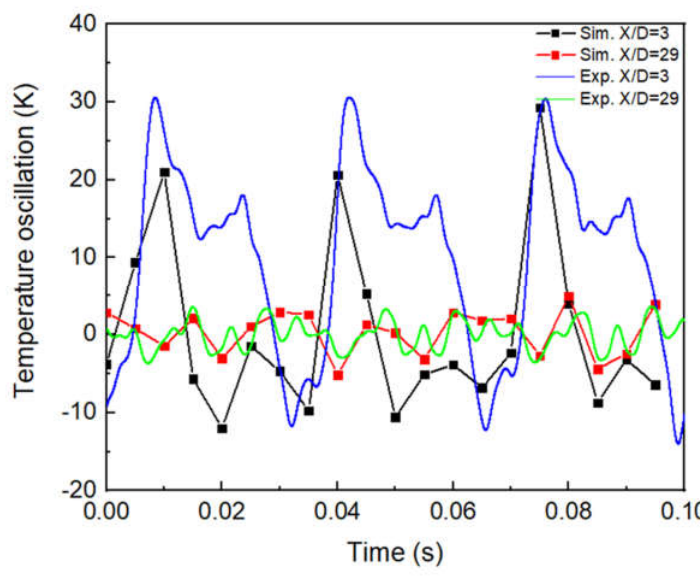
Figure 17. The experimental and numerical temperature comparison in pulsating flow.